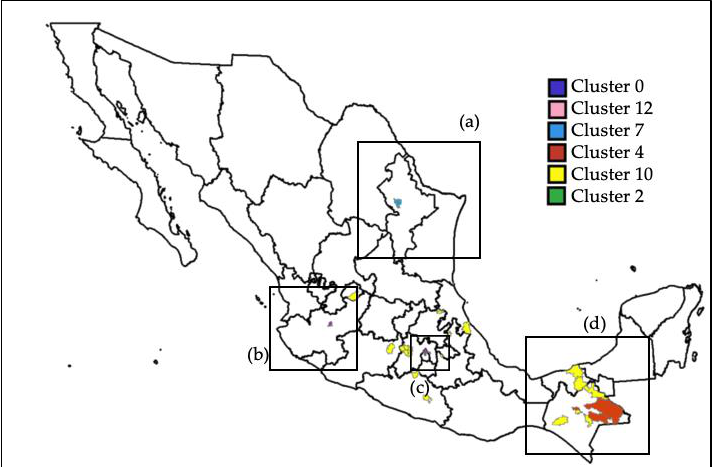
Figure 5. Spatial distribution of municipalities in extreme clusters.